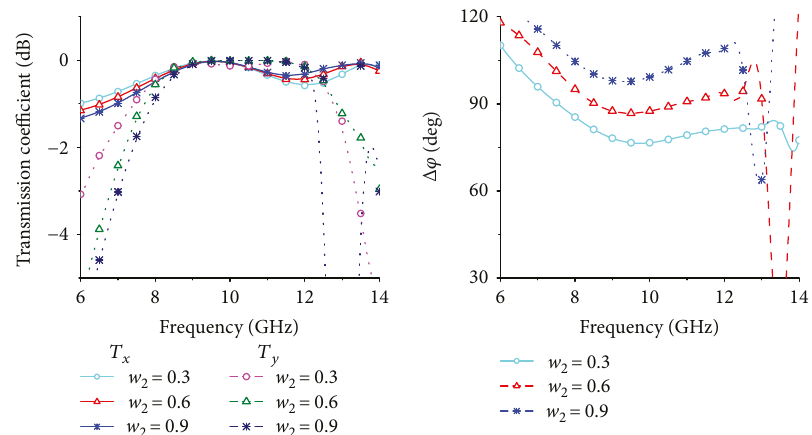
Figure 5: Simulation results of the transmitted wave for di ff erent w